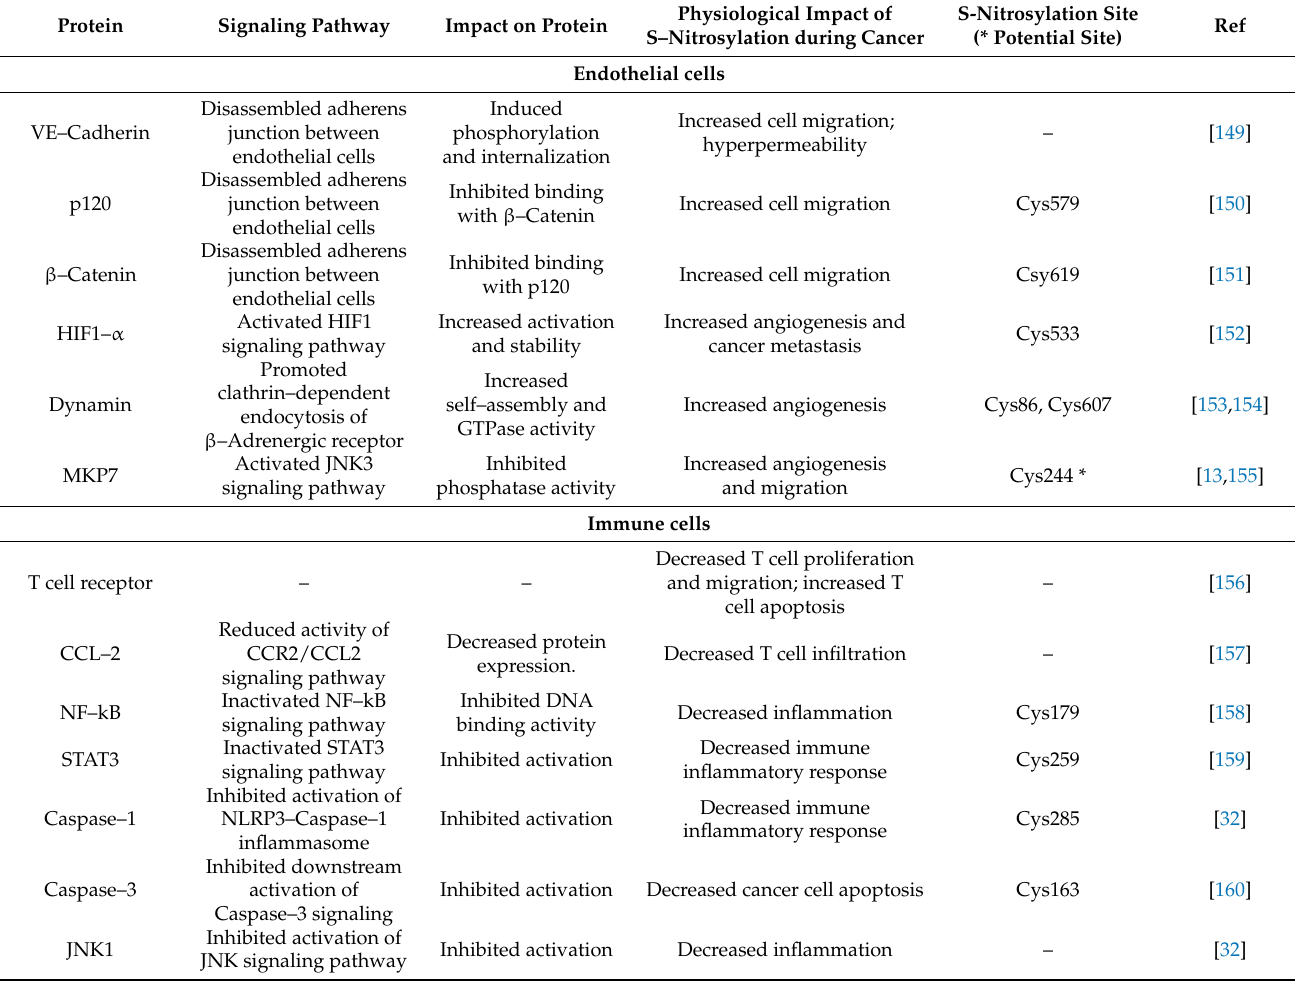
Table 2. Different S-nitrosylated proteins in the resident cells of the TME and their impact on cancer. Protein Signaling Pathway Impact on